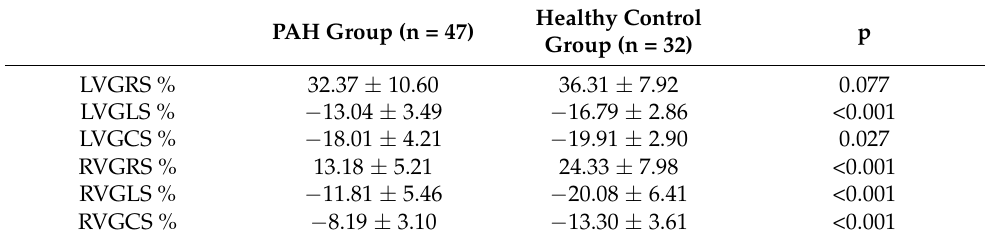
Table 3. Comparison of myocardial strain values between the PAH and healthy control